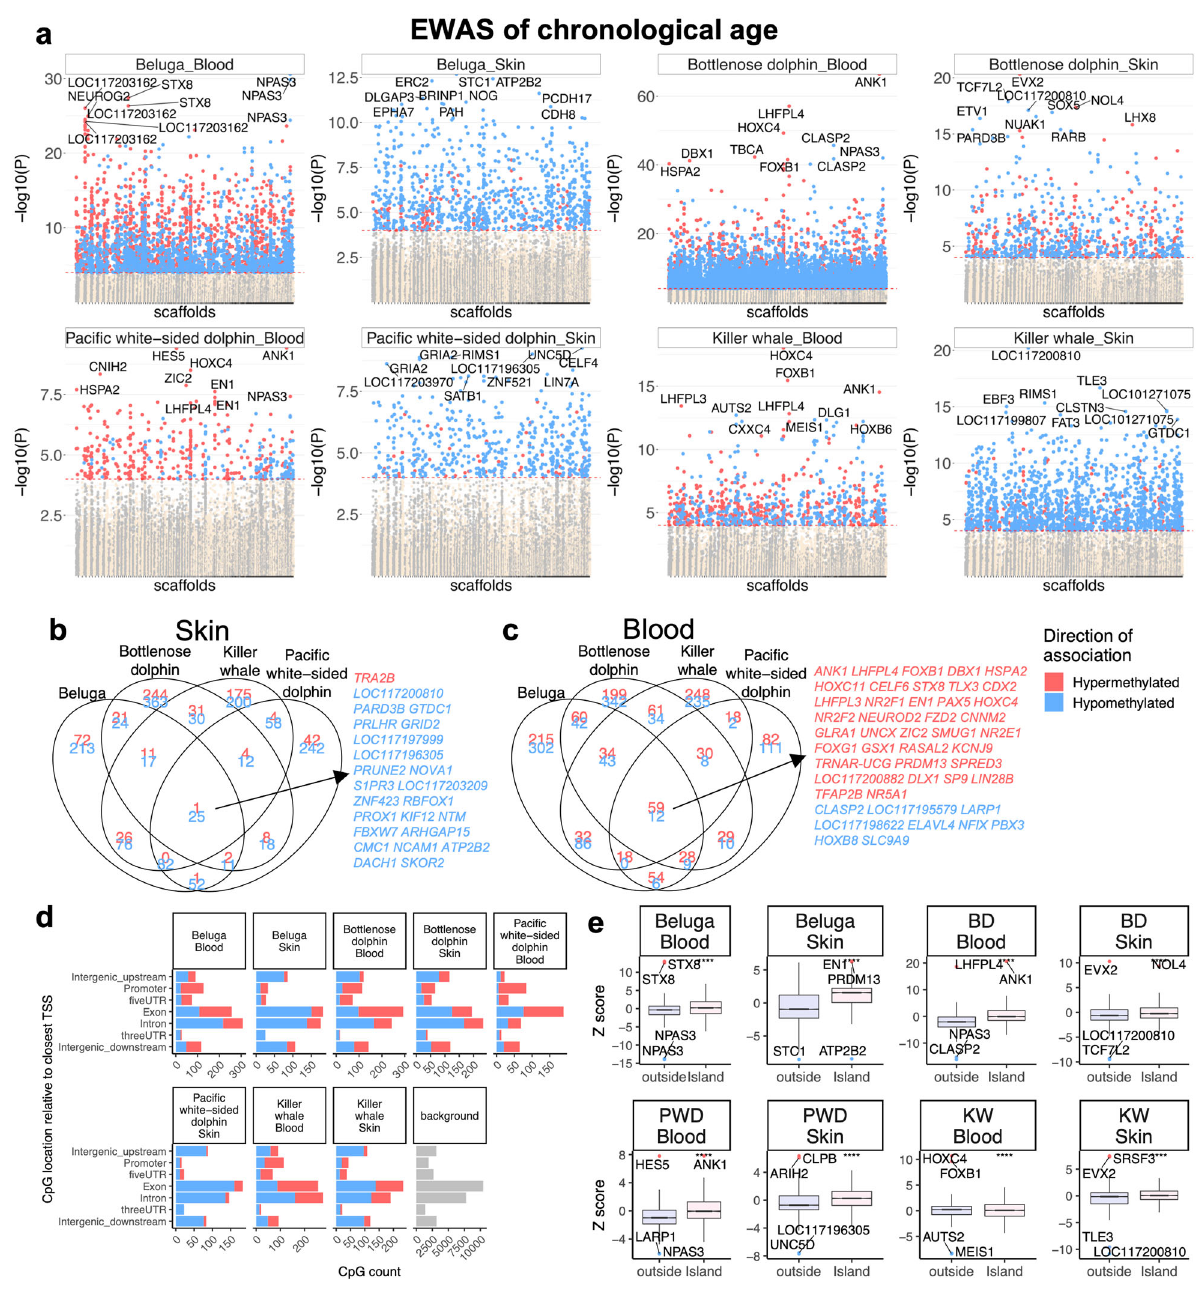
Fig. 3 Epigenome-wide association (EWAS) of chronological age in skin and blood of four Odontoceti species. a Manhattan plots of the EWAS of chronological age. The coordinates are estimated based on the alignment of Mammalian array probes to killer whale (GCF_000331955.2_Oorc_1.1) genome assembly. The direction of associations with P < 0.0001 (red dotted line) is highlighted by red (hypermethylated) and blue (hypomethylated) colors. Top 10 CpGs were labeled by the neighboring genes. Venn diagrams representing the overlap of aging-associated CpGs in skin ( b ) and blood ( c ) of these species. The conserved DNAm aging loci in blood and skin samples were marked by neighboring gene symbol. This analysis was limited to top CpGs that were selected at P < 0.0001 and further fi ltering based on z score of association with chronological age for up to 500 in a positive or negative direction. The number of selected CpGs: beluga blood, 1000; beluga skin, 639; bottlenose dolphin blood, 1000; bottlenose dolphin skin, 68; Paci fi c white-sided dolphin blood, 490; Paci fi c white-sided dolphin skin, 564; killer whale blood, 935; killer whale skin, 665. d Location of top CpGs in each species relative to the closest transcriptional start site. e Box plot represents 25th and 75th percent quartiles, the line represents the median, and whiskers are 90% of aging association strati fi ed by CpG island status in killer whale genome. * p < 0.05, ** p < 0.01, *** p < 0.001, **** p <